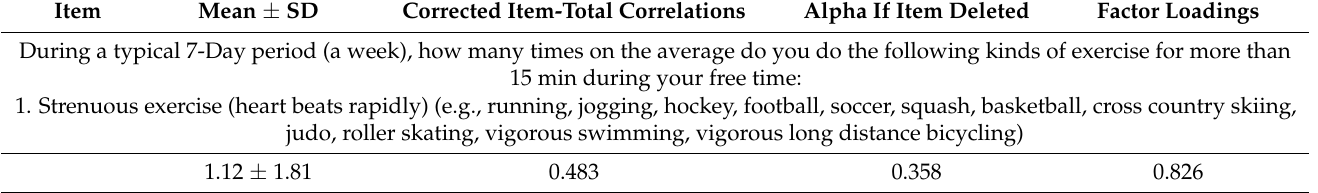
Table 1. Item means and standard deviations, corrected item-total correlations, alpha if items deleted and factor loadings of the items of the Croatian GSLTPAQ (N = 823). Item Mean ± SD Corrected Item-Total Correlations Alpha If Item Deleted Factor Loadings